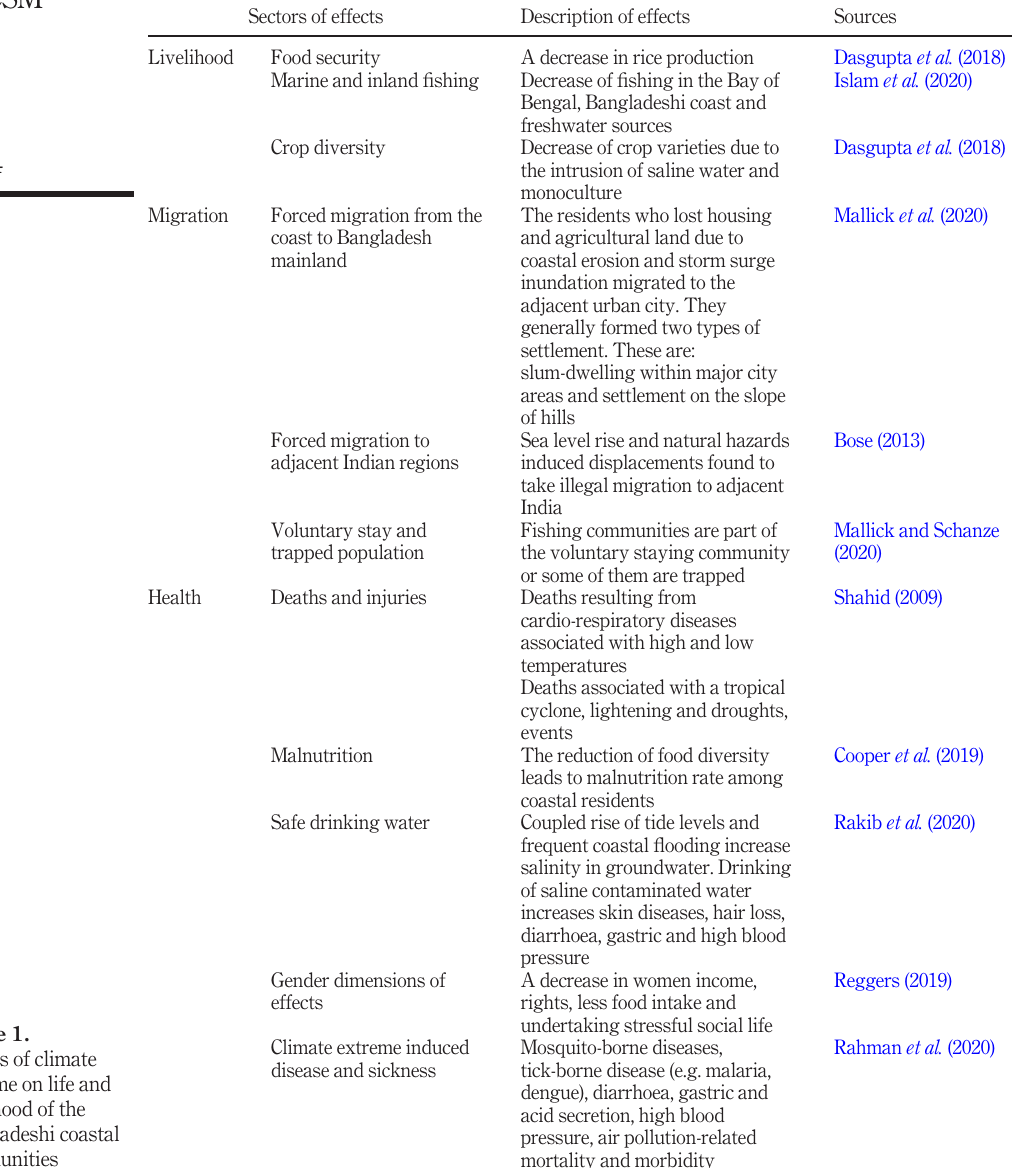
Table 1. Effects of climate extreme on life and livelihood of